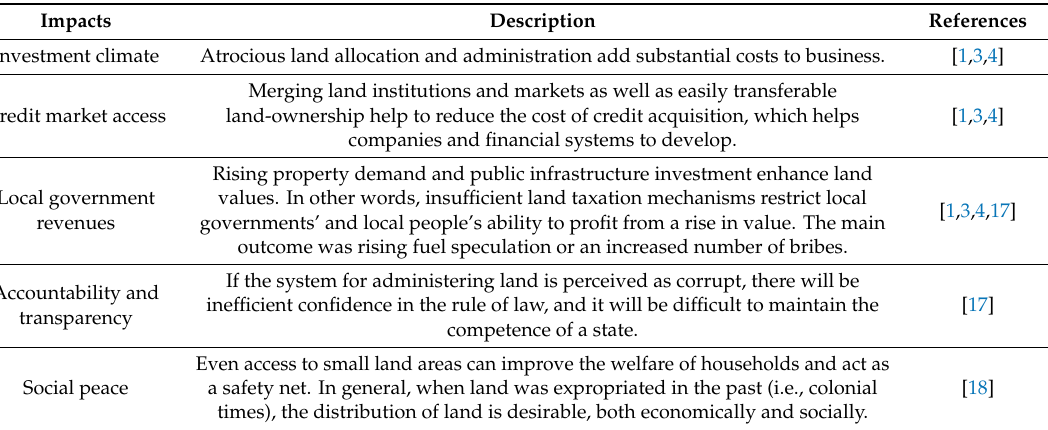
Table 2. Worldwide evidence of land distribution and economic